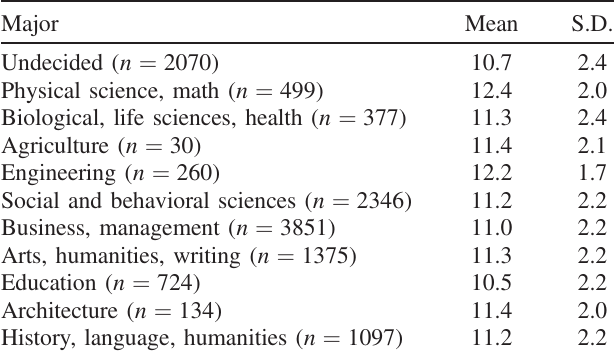
TABLE VI. Average science knowledge scores by major.